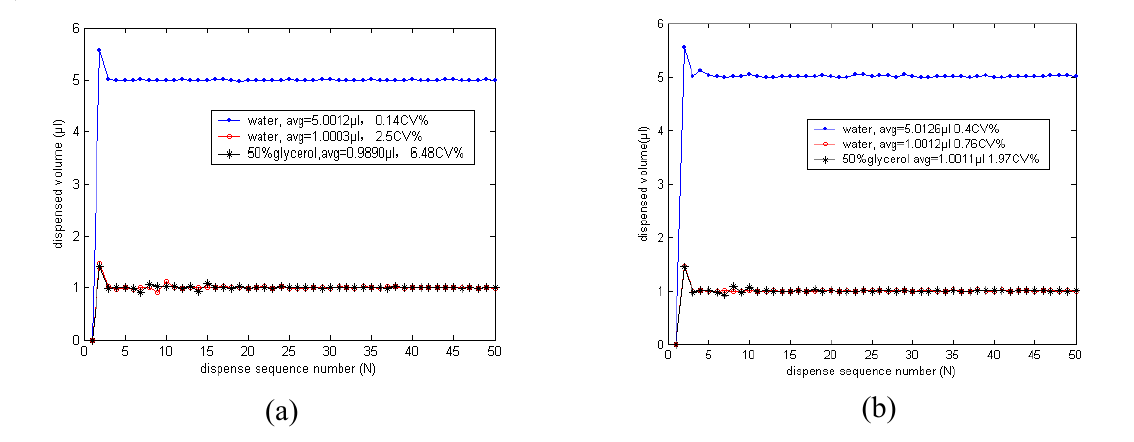
Figure 13. Dispensed volume for each cycle with different control strategies, desired volume and reagent.